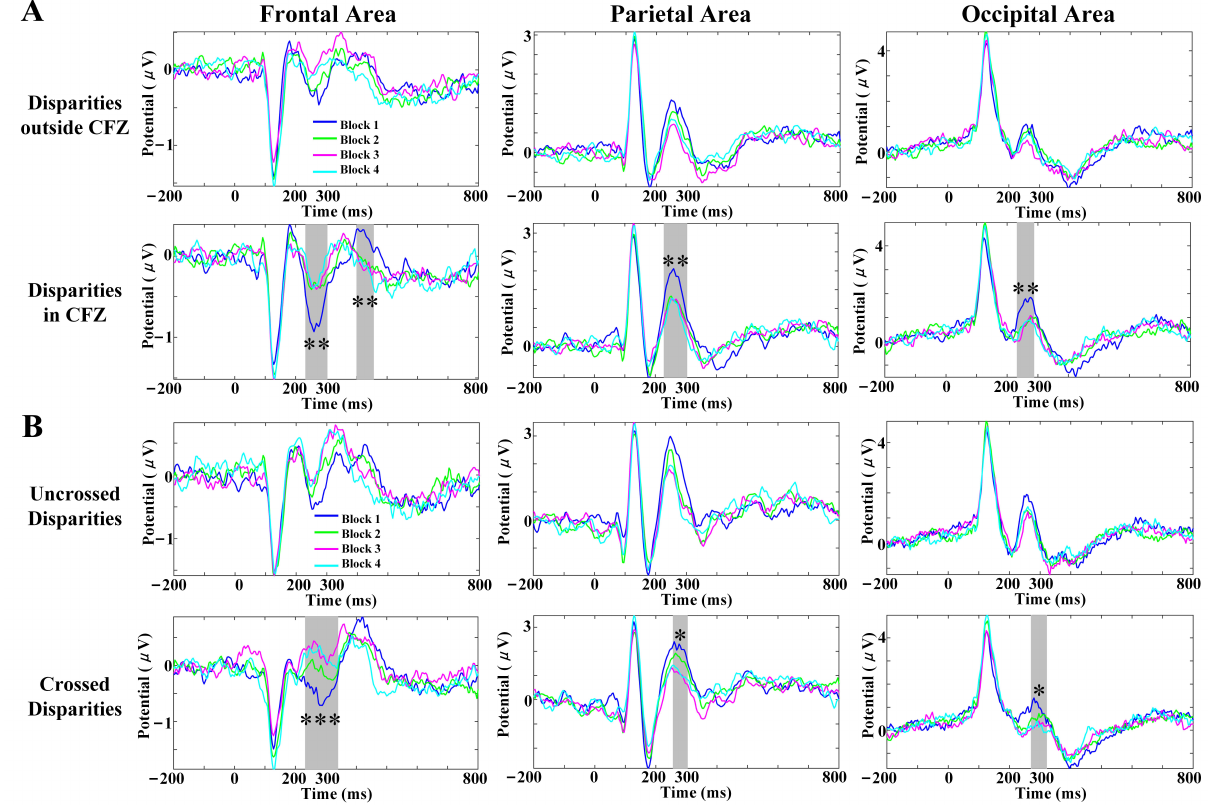
Figure 5. Effects of SVF levels among different disparities on VEPs components. ( A ) VEPs waveform images at frontal, parietal and occipital areas of 4 blocks for disparities outside CFZ and disparities in CFZ, respectively. ( B ) VEPs waveform images at frontal, parietal and occipital areas of 4 blocks for uncrossed disparities and crossed disparities, respectively. The grey underlining denote time region of peak amplitude significant difference after the cluster method corrected, *** p < 0.001, ** p < 0.01, * p <